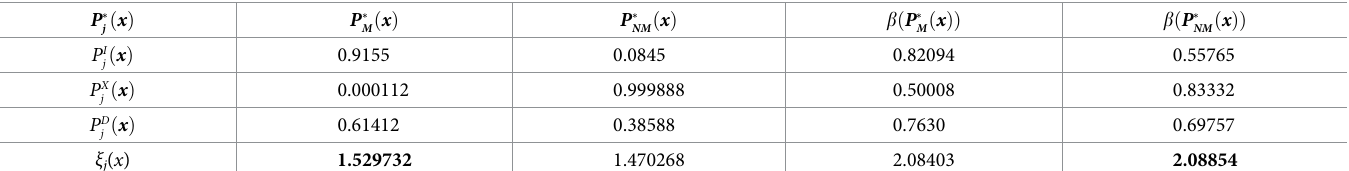
Table 1. A toy example of the Beta normalization scheme with different probability values. P respectively. Other symbols have usual meanings as described above.